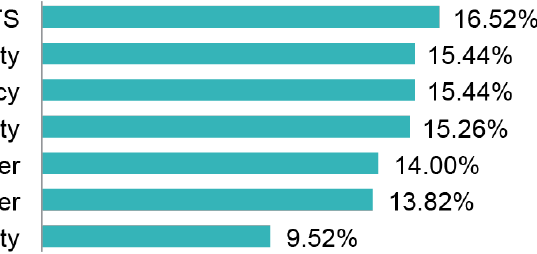
18 of 21 Figure 19. Subjective workload perceived by the users. In the qualitative evaluation (free text), users singled out valid and timely infor- mation, especially on security issues, as advantages of the system; the beautiful design and the nice presentation of the information were noted as particularly positive elements. The absolute majority of the users indicated that they would like more audio warnings as well as more options for connectivity (e.g., via Bluetooth), while some users also men- tioned that personalization in the sound would be most welcomed so that they can choose different audio for each case or warning. In addition, the users stated that they would like to have on display the estimated time to an event (e.g., collision time in the case of a crash) when this is for security reasons. In total, 95% of users state that they expect the system to provide a positive impact